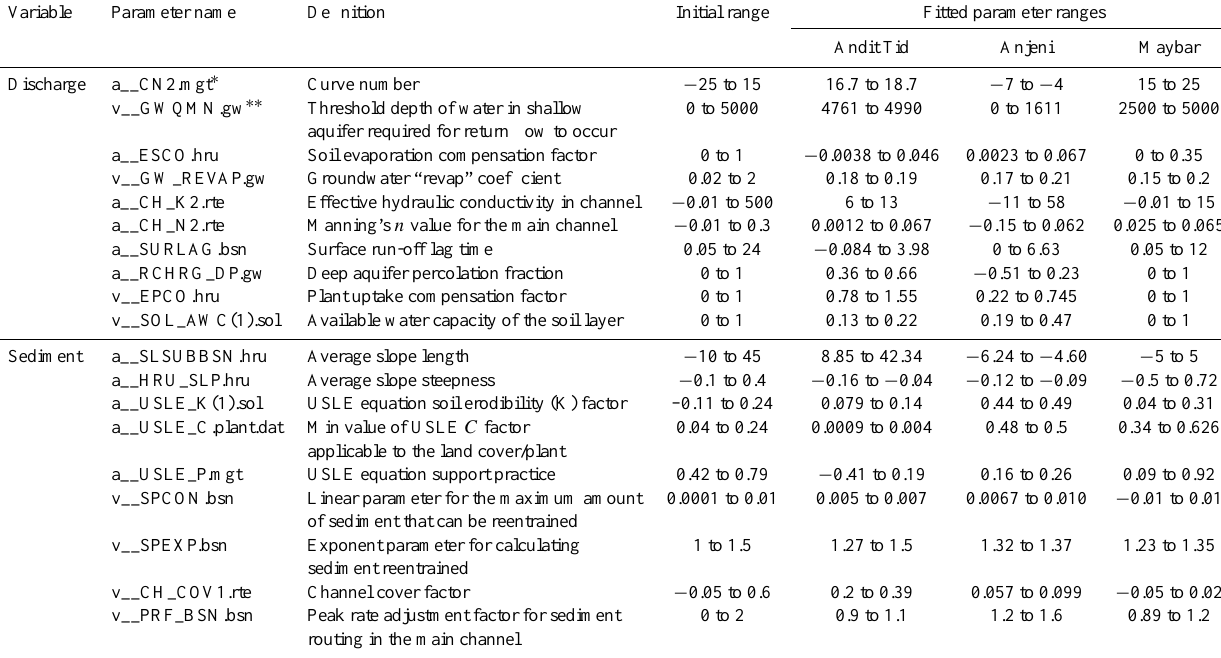
Table 2. SWAT parameters used for discharge and soil loss calibration with initial ranges and fitted final parameter ranges.